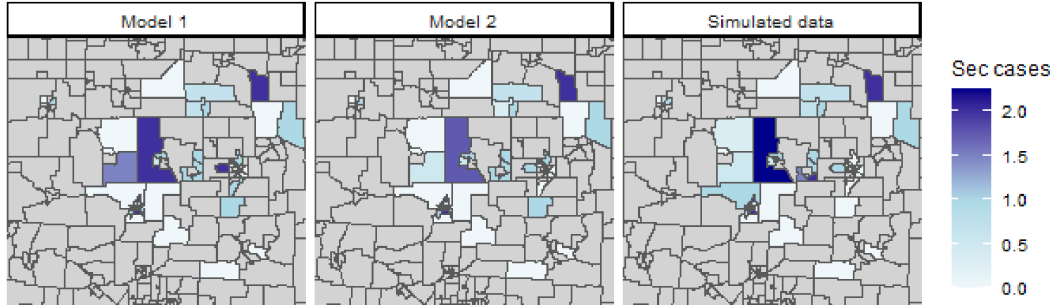
Figure 6. Median number of secondary transmission per case in each census